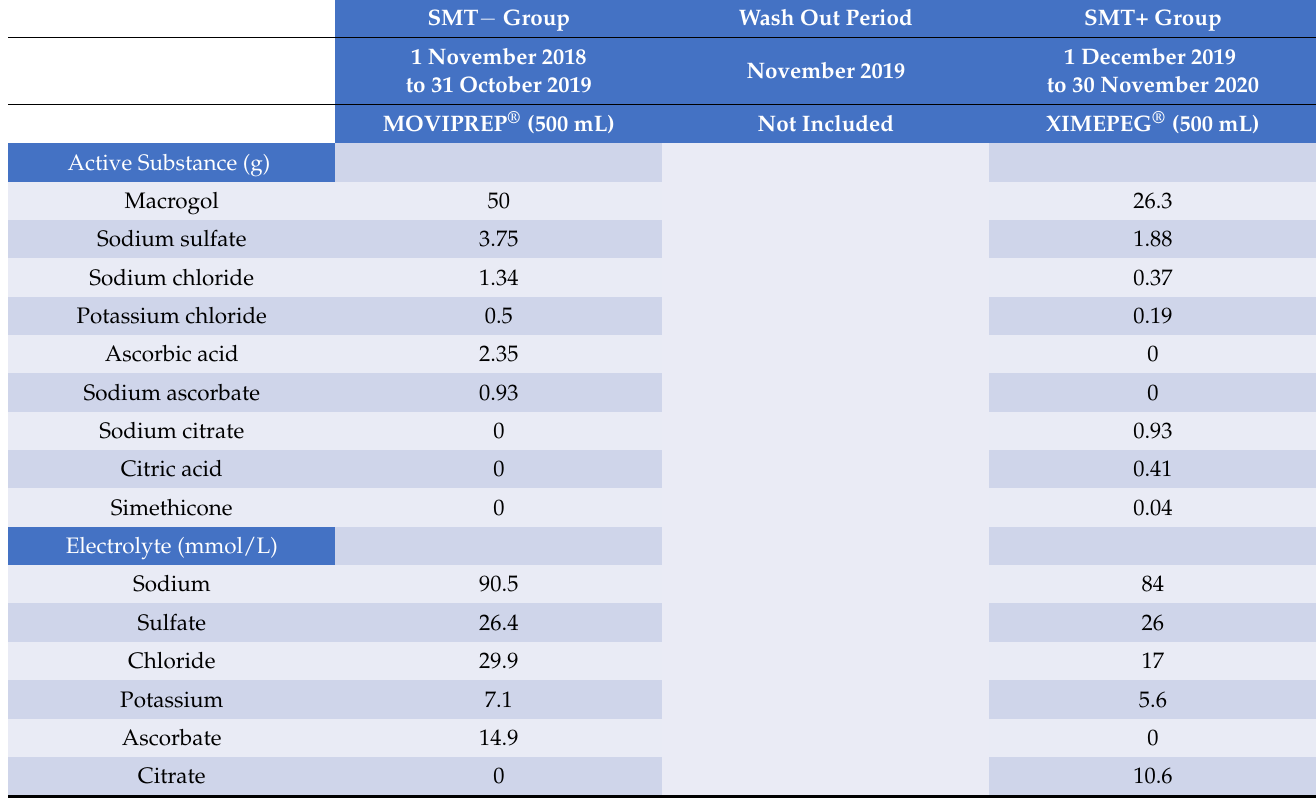
Table 1. Study periods and composition for 500 mL of Ximepeg ® and Moviprep ® solutions. Active substances are in grammes, and electrolytes are in Millimoles per liter. SMT − stands for “without simethicone” whereas SMT+ means “with